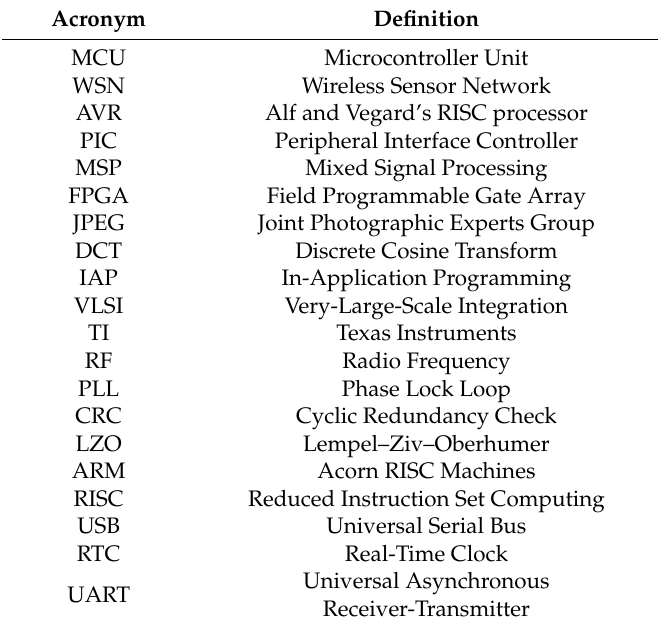
Table 1. Acronyms used in this